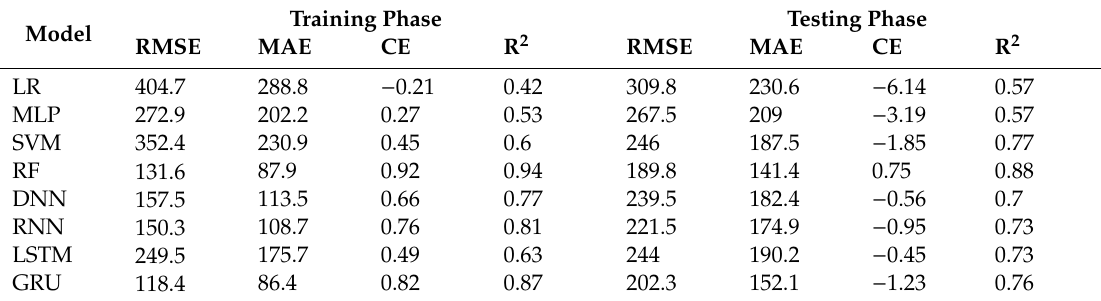
Table 7. Comparison of the predicted electricity consumption with 1-month-ahead predictions of eight models in the testing